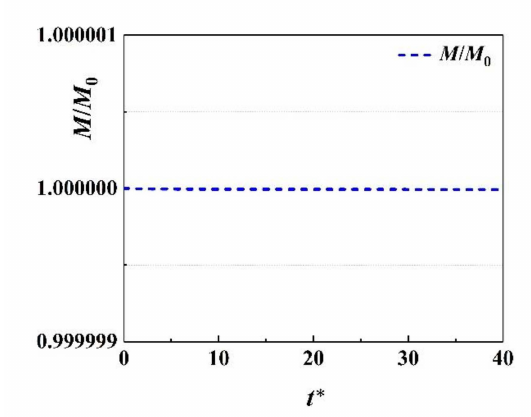
Figure 6. Variation of the normalized total system mass with dimensionless